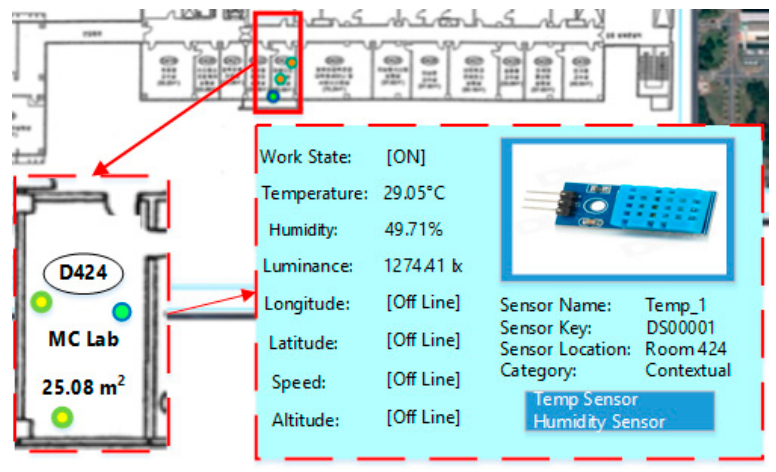
Figure 11. Geo-sensor visualization for Internet of Things (IoT) environments.